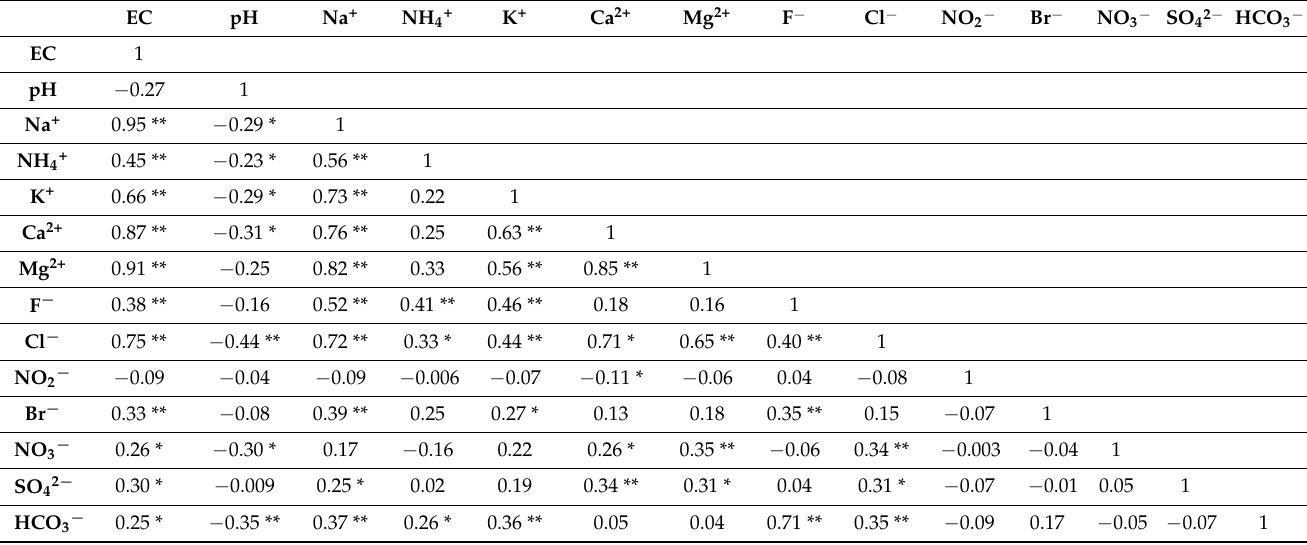
Table 4. Correlation matrix between the hydrochemical variables in the Maku–Bazargan–Poldasht